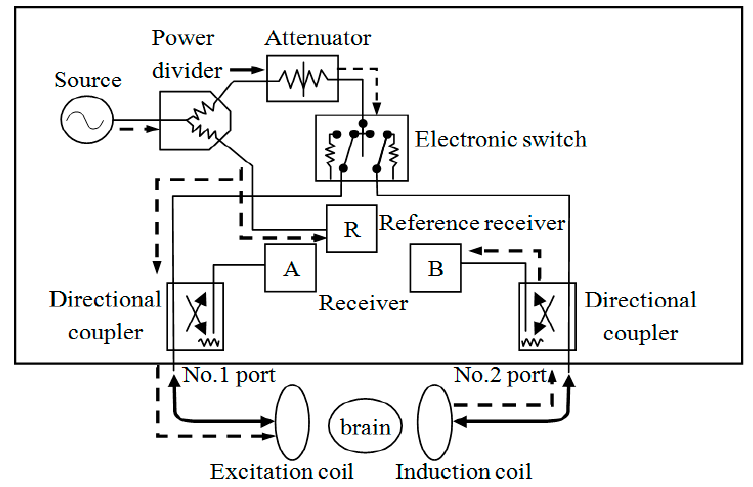
Figure 1. The equivalent circuit of the noninvasive and noncontact system of magnetic induction.